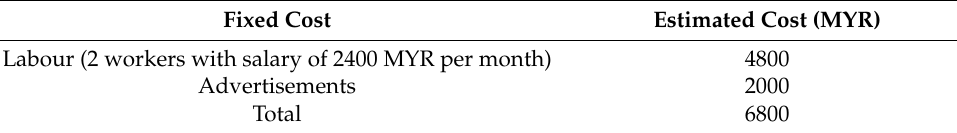
Table 24. Estimated fixed expenses per